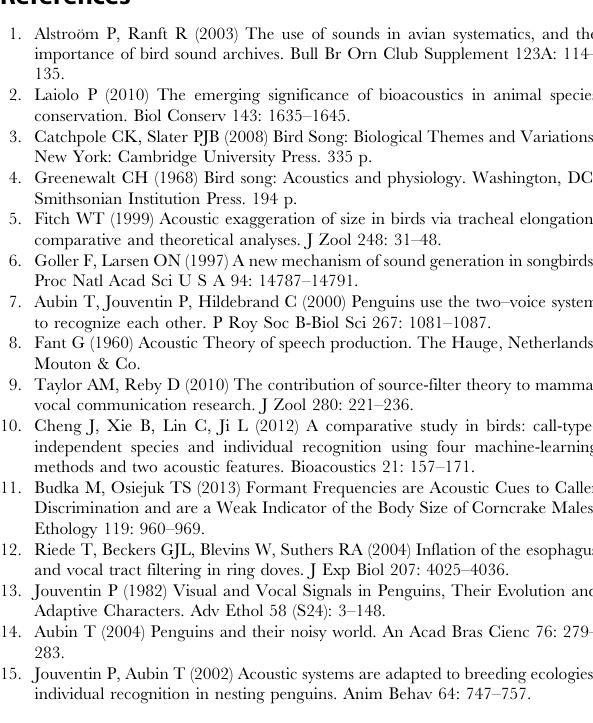
Table S1 Published studies on the vocal repertoire of the African Penguin. (PDF) Video S1 Contact calls uttered by adult African Pen- guins to maintain cohesion with colony members located out of visual